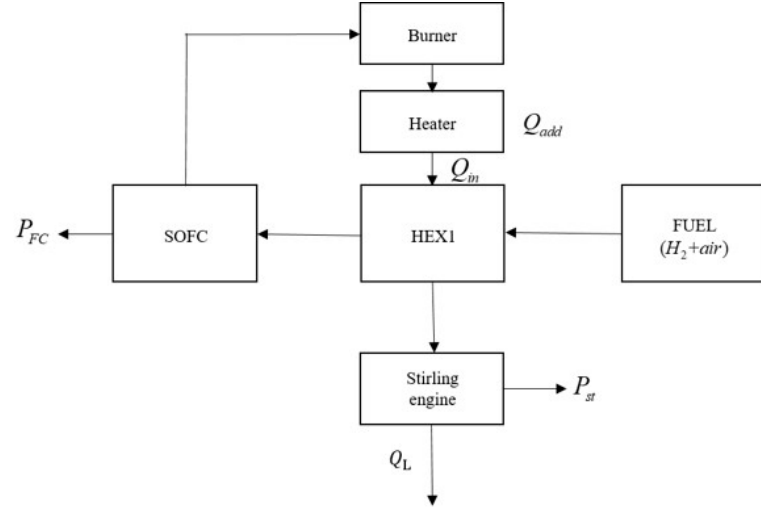
Figure 6. System loop of the hybrid SOFC-SE system with heat